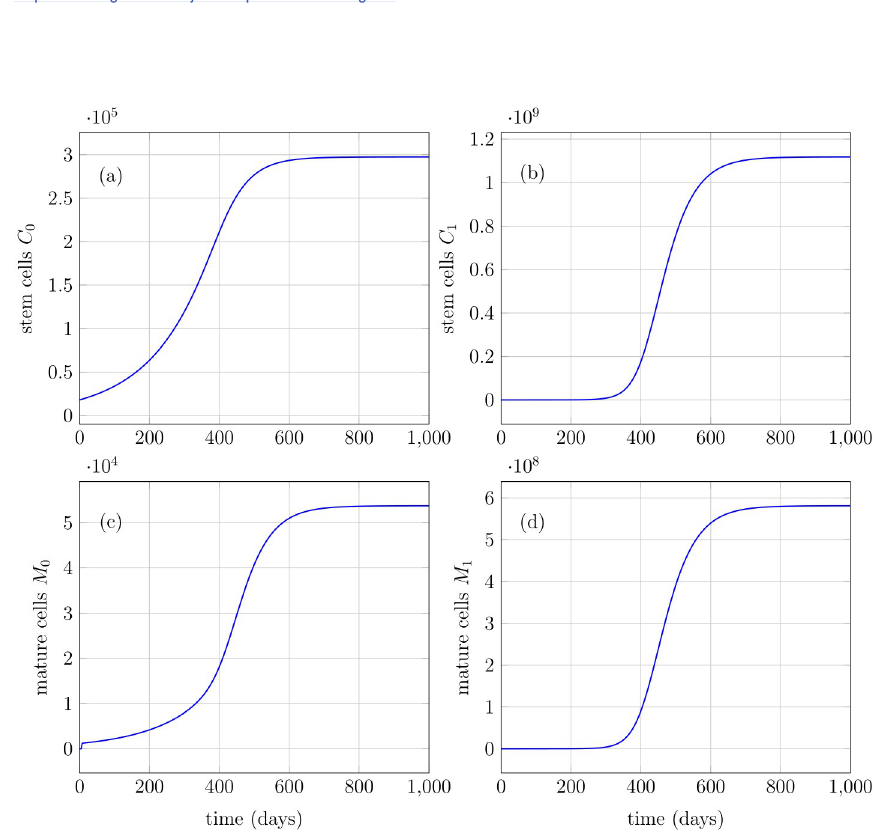
Fig 4. Healthy and mutated stem and mature cells. (a) Healthy stem cells with initial value of 18000 mL − 1 grow exponentially and converge to a steady-state. (b) Mutated stem cells with initial condition equal to zero, increase exponentially and attain a steady-state at relatively large value. (c) Healthy mature cells depict a similar behavior with initial condition equal to zero. (d) Mutated mature cells depict a similar behavior with initial condition equal to zero.